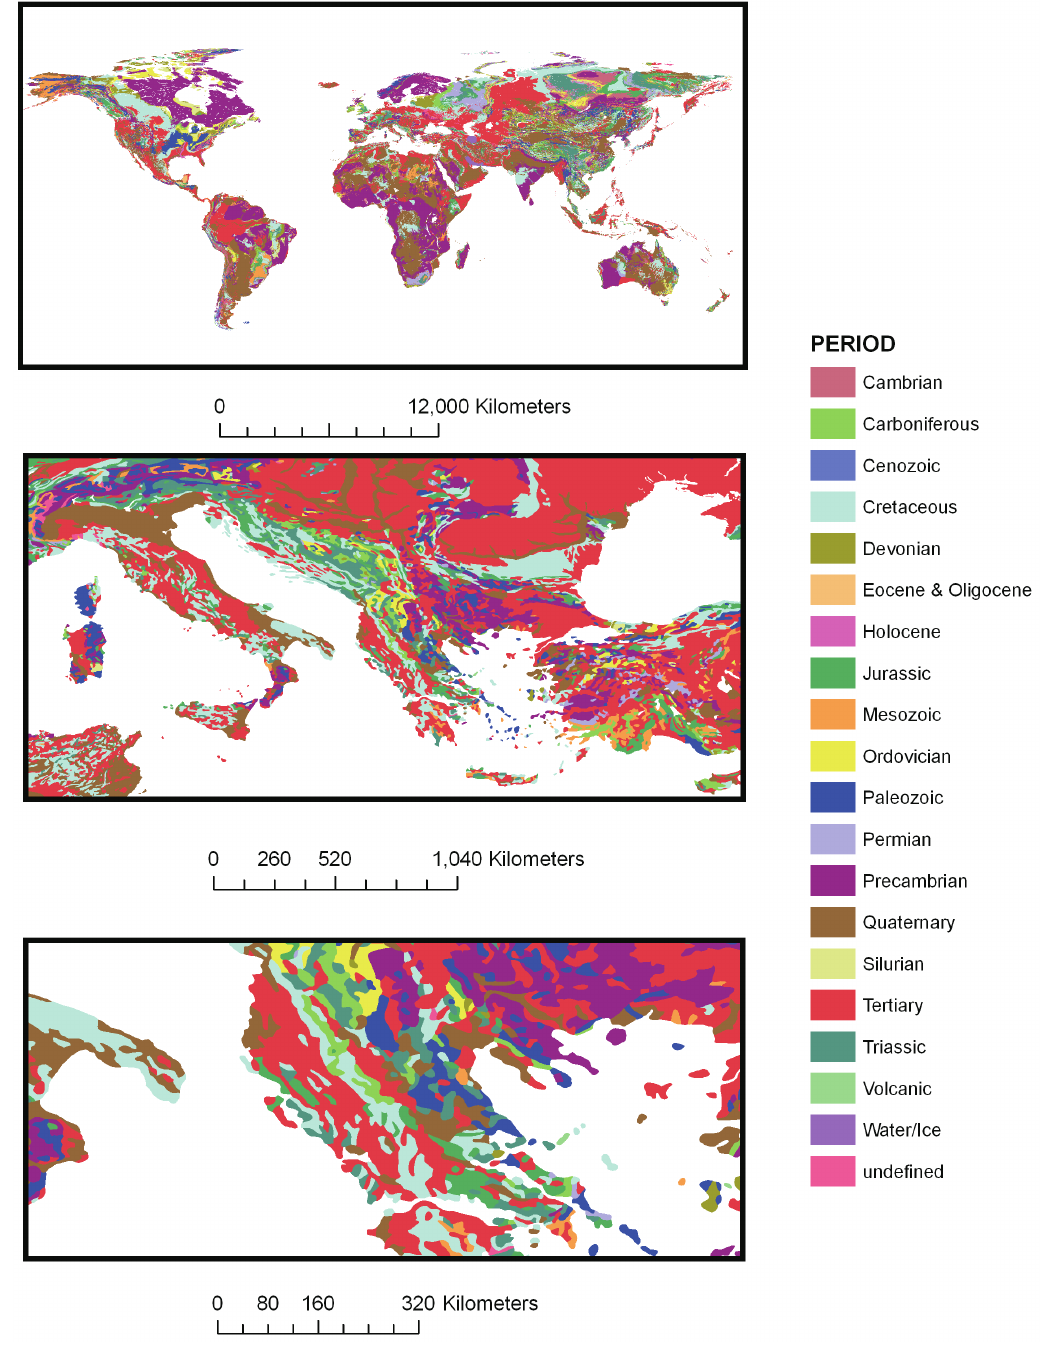
Fig. 5. Geology (GG) as given by Hearn et al. (2003): (a) Global view (b) focussed on South-East Europe, (c) focussed at high-resolution in South-East